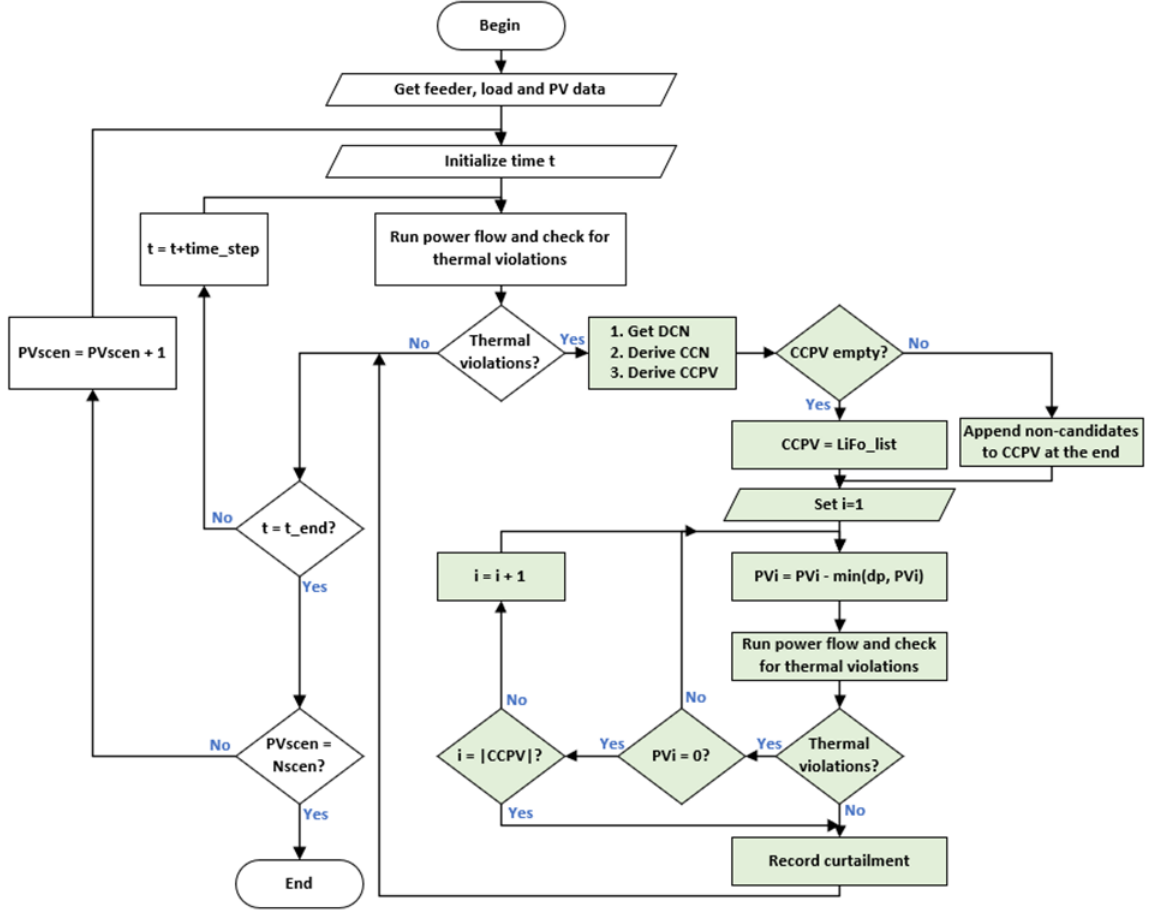
Figure 2. Electric distance-based, last-in, first-out ( ed-LiFo ) flowchart in a quasi-static time-series ( QSTS ) simulation for photovoltaic (PV) curtailment risk assessment.